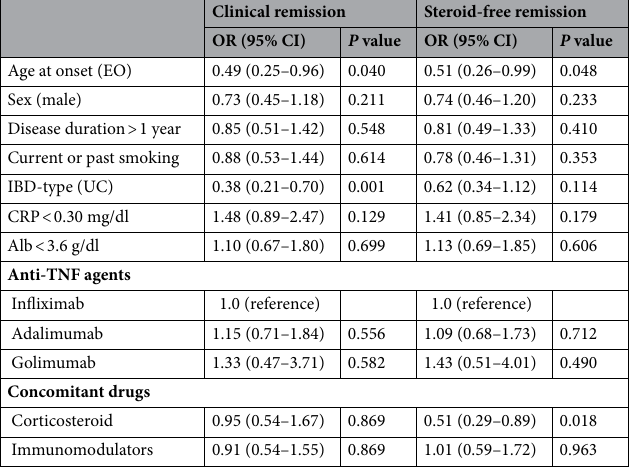
Table 2. Multivariate analysis of factors for clinical or steroid-free remission after 52 weeks of anti-TNF treatment (n = 379). Alb albumin, Anti-TNF anti-tumor necrosis factor, CI confidence interval, CRP C-reactive protein, EO elderly onset, IBD inflammatory bowel disease, OR odds ratio, UC ulcerative colitis.